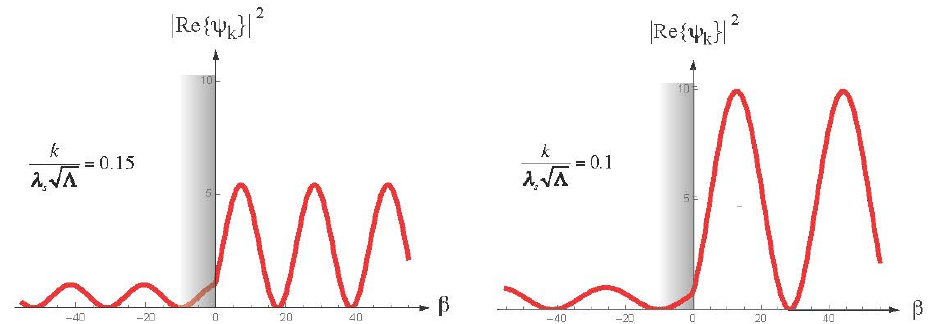
Figure 2. Evolution in superspace of the Wheeler–De Witt (WDW) solution which illustrates the anti-tunnelling effect produced by the effective potential barrier (grey shaded region) due to the dilaton potential (38). The wave function is not damped but parametrically amplified provided k < λ s √ Λ , and the effect is larger for smaller k .